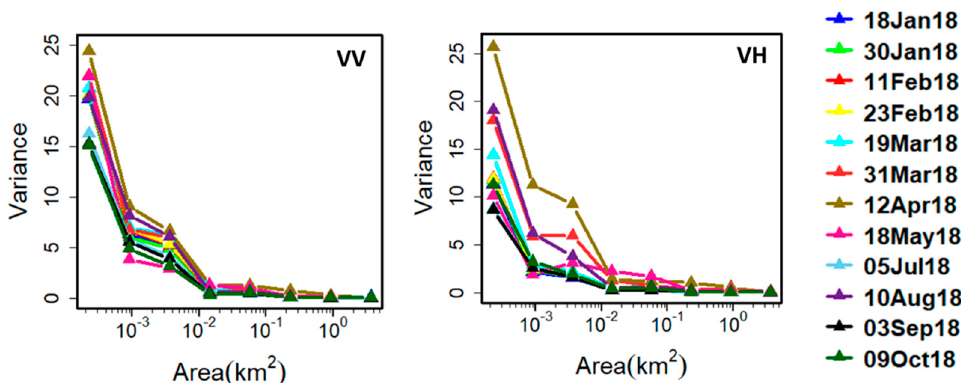
Figure 12. Temporal evolution of the spatial variance of Sentinel-1 VV ( left ) and VH ( right ) BSC coefficients in ascending mode for homogenous barren land covered with snow in the winter time over the Swiss Alps, Davos during 2018 as a function of scale.